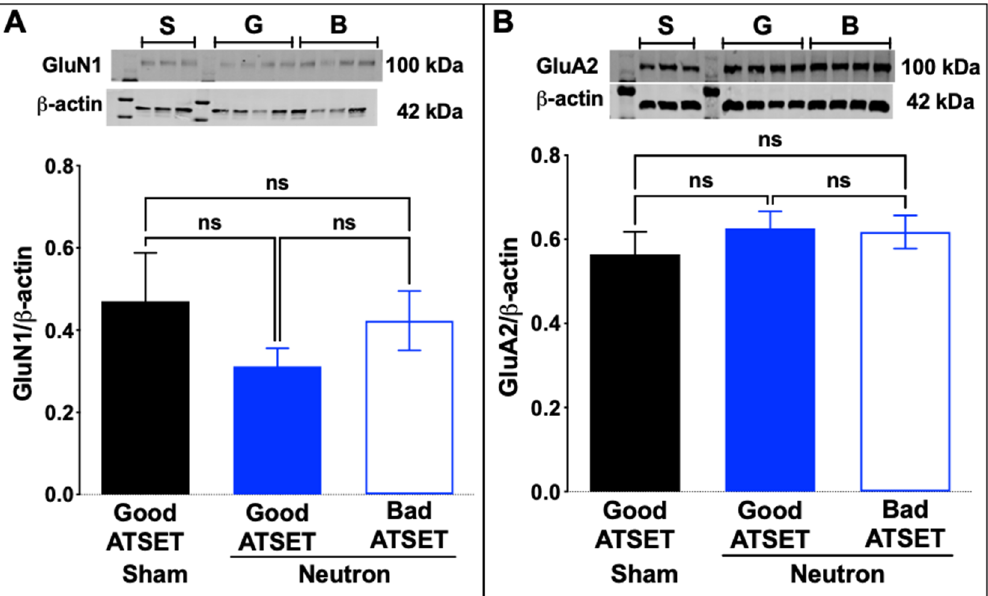
Figure 7. Western blot analyses for the ionotropic glutamate receptors in the sham and the low dose neutron irradiated groups of rats. ( A ) No significant differences were appreciated in the GluN1 subunit of the NMDA receptor between the three groups of rats ( B ) No significant change was observed in the expression levels of the GluA2 subunit of the AMPAR between the three groups of rats. Crude synaptosomal fractions from three-four animals per group were used in the assessment and statistical significance ( p < 0.05) was determined using non-parametric, Kruskal–Wallis t -test.